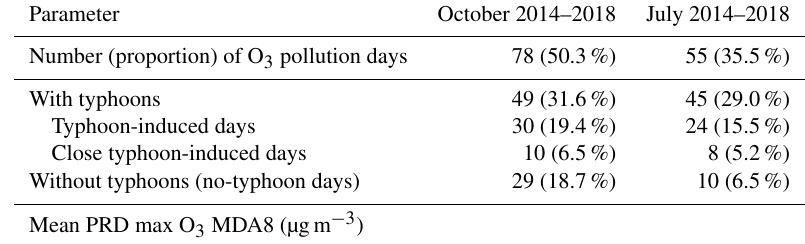
Table 1. The numbers and proportions of O 3 pollution days and O 3 concentrations for various scenarios.